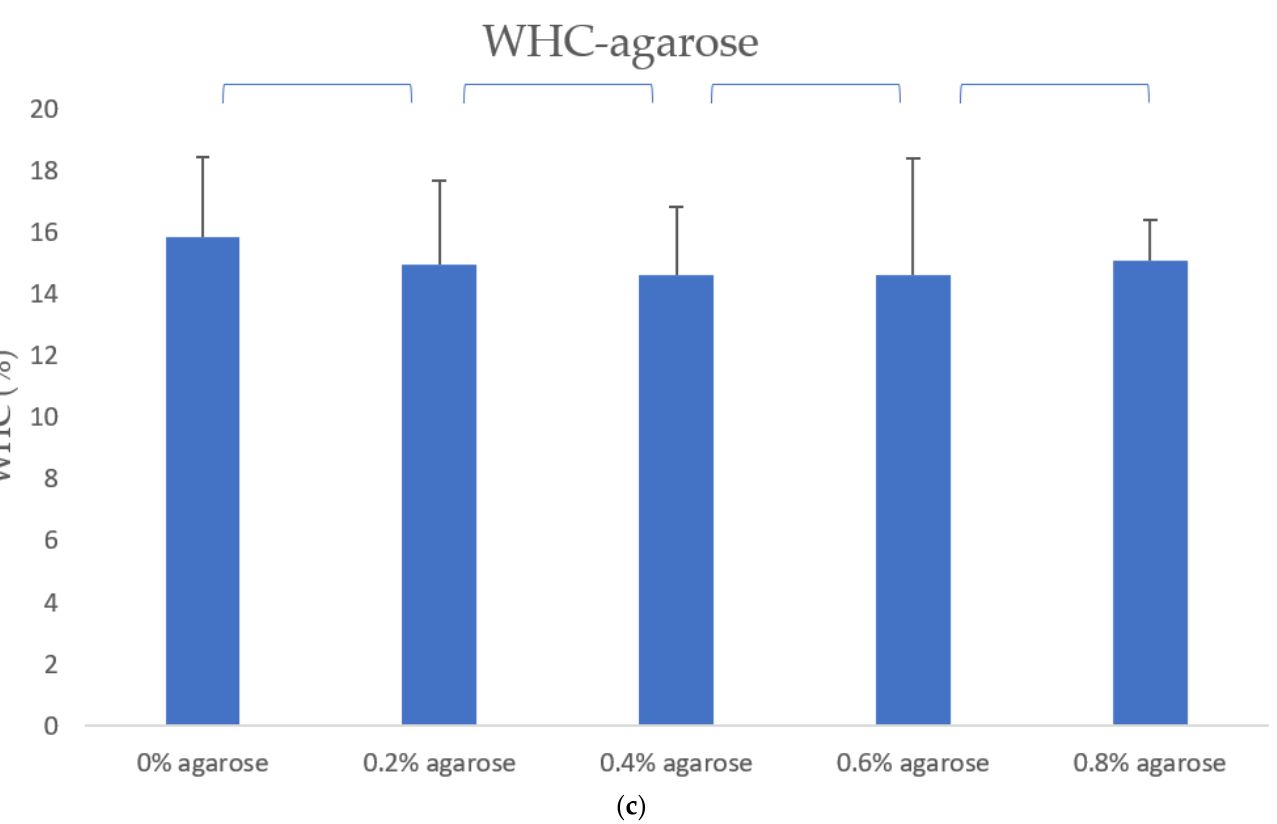
Figure 4. The WHC test results. * means that there are statistical significances between the two adjacent gelatin–alginate– agarose concentrations.